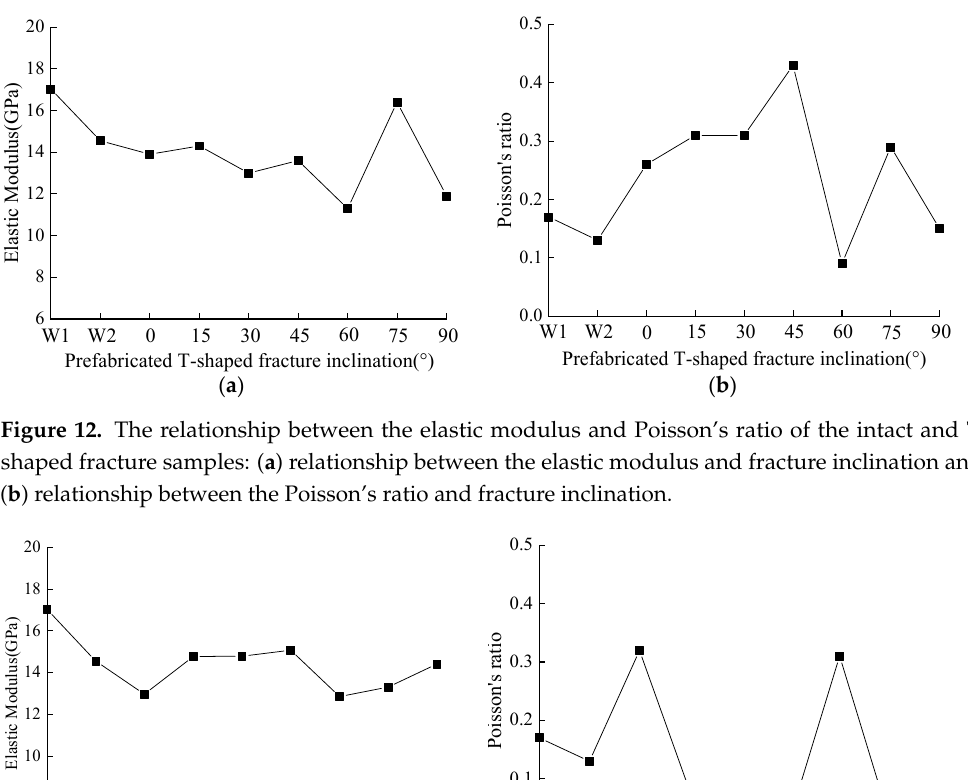
Figure 11. Relationship between the elastic modulus, Poisson’s ratio, and fracture inclination of intact and single fracture samples: ( a ) relationship between the elastic modulus and fracture inclination and ( b ) relationship between the Poisson’s ratio and fracture inclination.